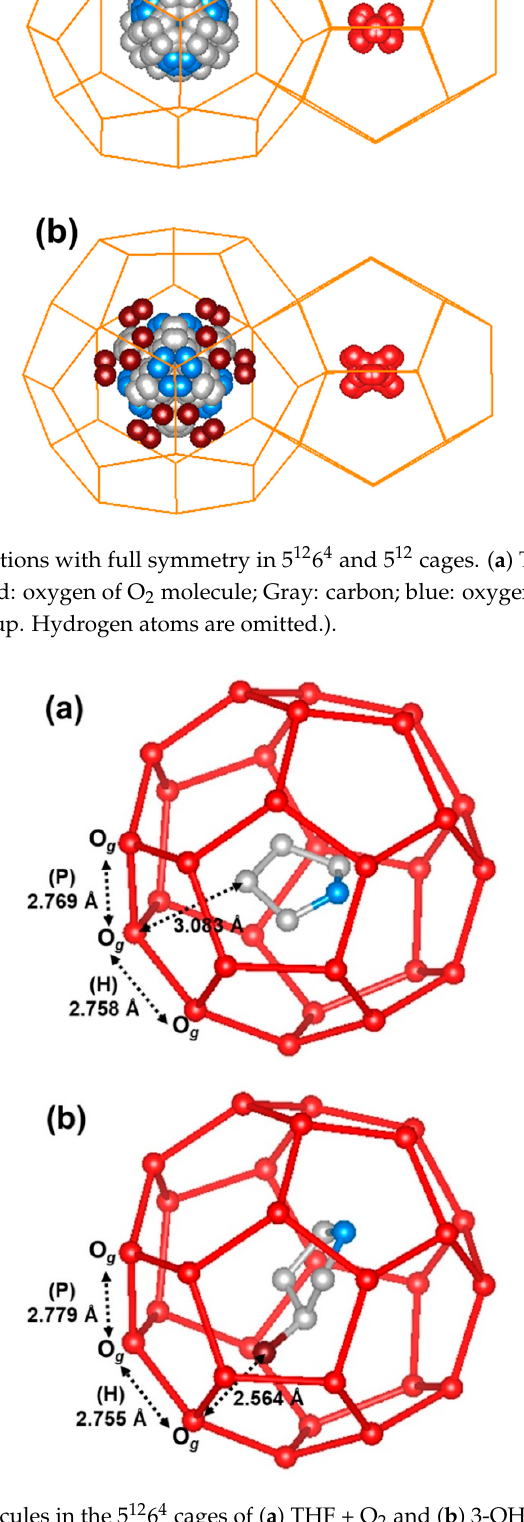
Figure 4. Guest molecules in the 5 12 6 4 cages of ( a ) THF + O 2 and ( b ) 3-OH THF + O 2 hydrates.